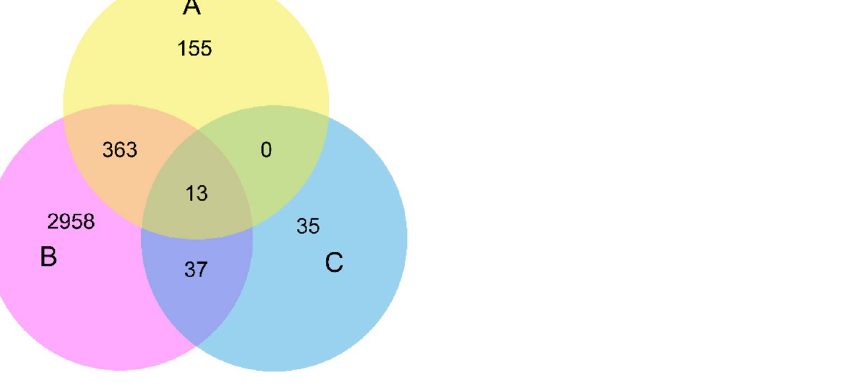
Figure 2. 3-set Venn diagram illustrating the count of unique and common genes in each possible pair of A, B, and C Subunits. The 13 genes identified from A ∩ B ∩ C are the hub genes used for motif analysis.